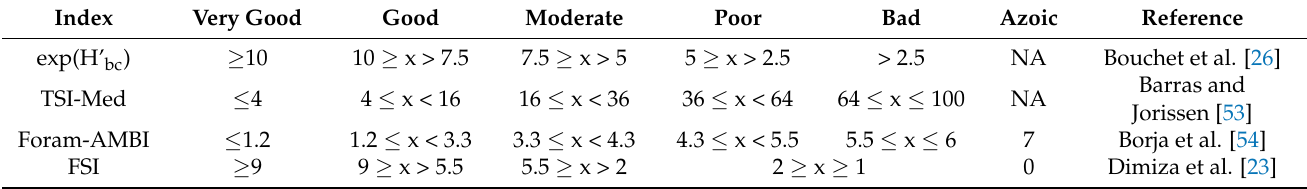
Table 1. Limits of the EQS classes proposed for each foraminiferal index. NA: Not Assigned. Index Very Good Good Moderate Poor Bad